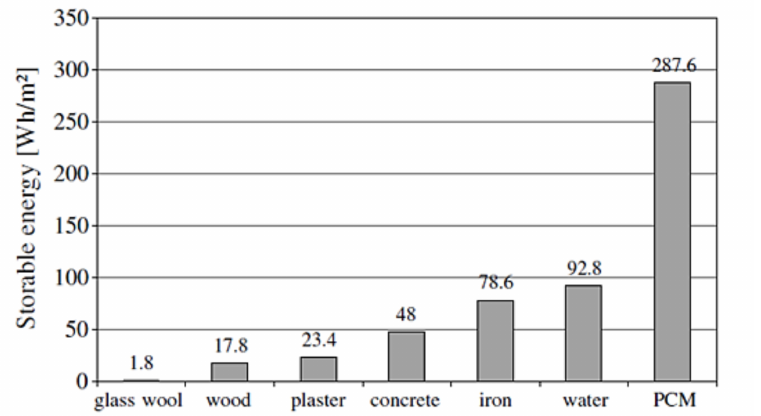
Figure 6. Maximum storable energy between 18 ◦ C and 26 ◦ C for 10 mm of material and for 24 h [42].